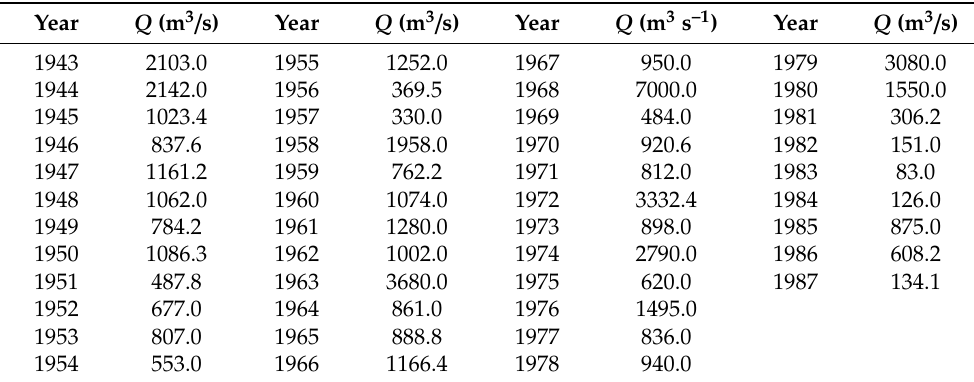
Table 1. Maximum annual flows recorded at hydrometric station